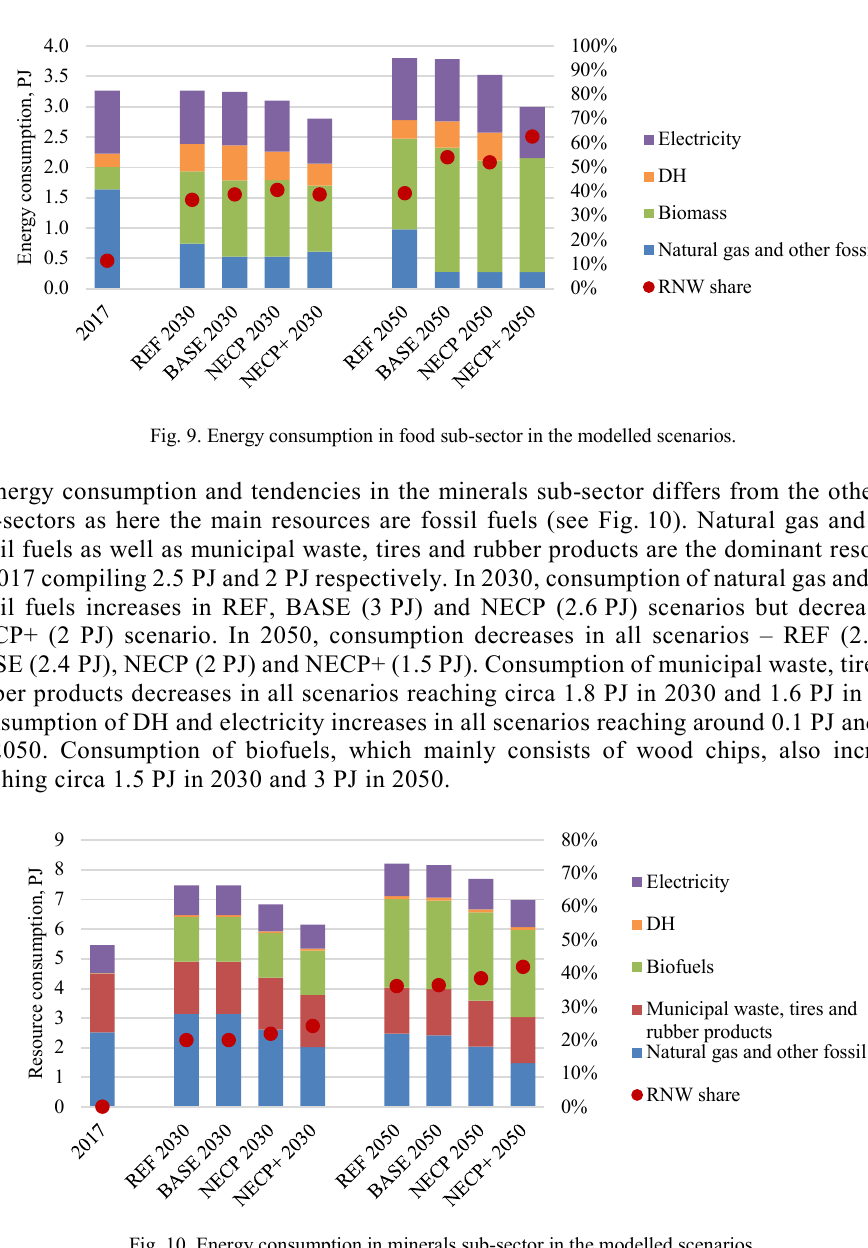
Fig. 10. Energy consumption in minerals sub-sector in the modelled